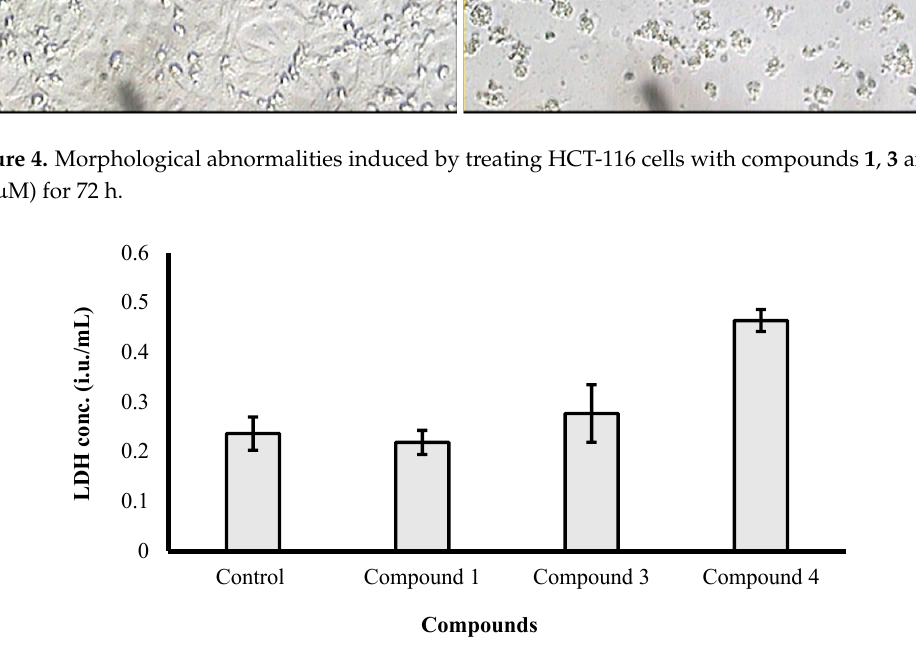
Figure 5. Assessing lactate dehydrogenase (LDH) leakage from HCT-116 after exposure to 10 µ M of compounds 1 , 3 and 4 for 72 h.